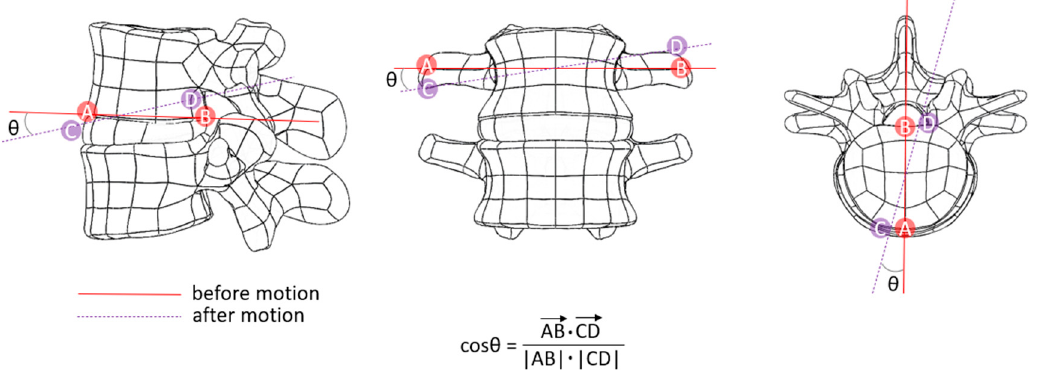
Figure 3. Method to determining the ROM ( θ represents the ROM).